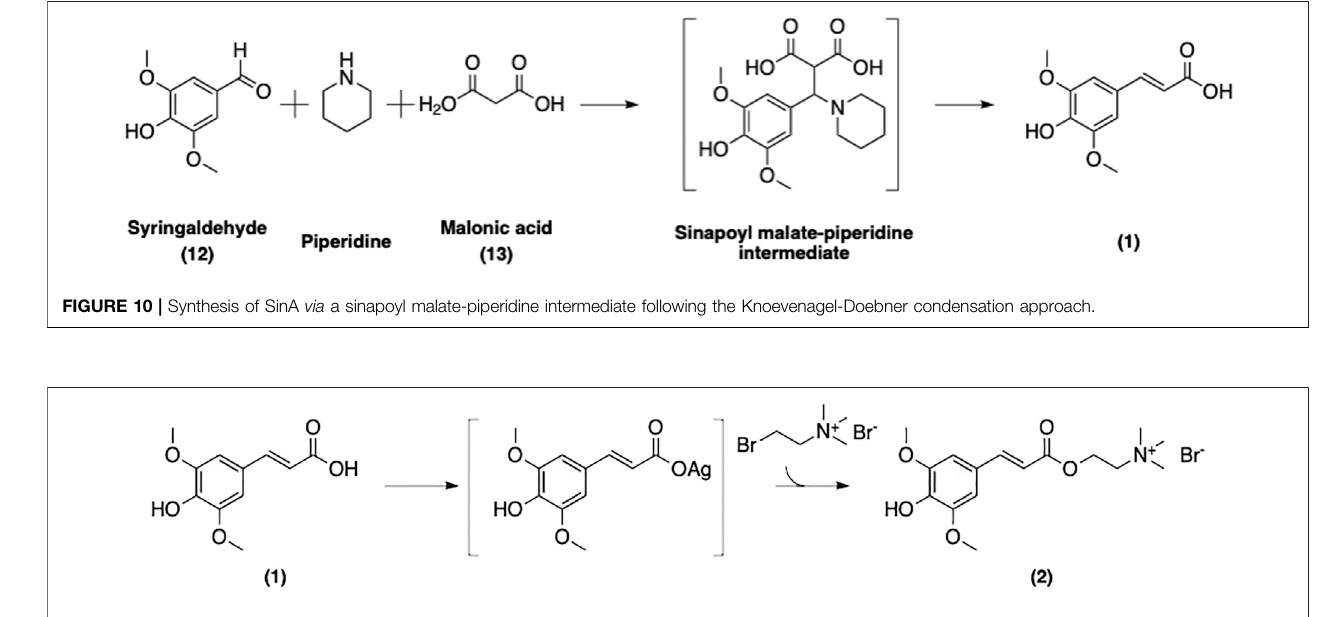
FIGURE 11 | Synthesis of sinapine described by Clausen et